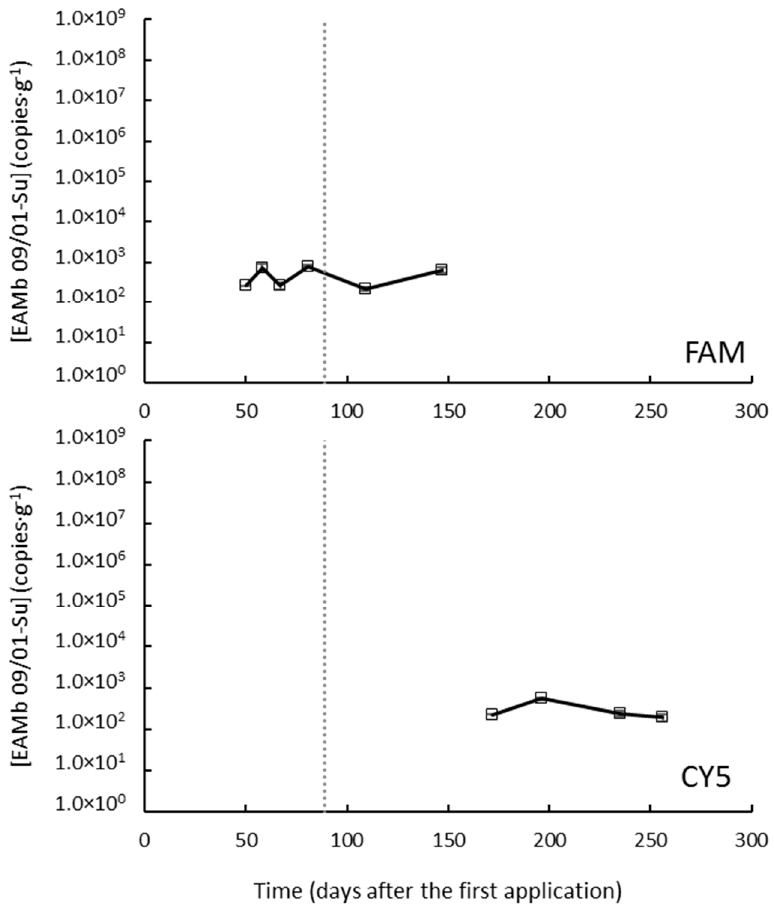
Figure 4. Concentrations of Metarhizium brunneum strain EAMb 09/01-Su in the substrate when applied as oil dispersion in a field trial at Caldes de Montbui under the traditional regime. The different panes correspond to different markers, labeled as denoted within each pane; EAMb 09/01-Su was not detected with the R610-labeled marker at any sampling point. Hollow symbols (in this case, all data points) stand for values above the limit of detection but below the limit of quantification, and missing data are measurements below the limit of detection. The vertical dotted line indicates the time of the second application. FAM stands for 6-carboxyfluorescein; CY5, for